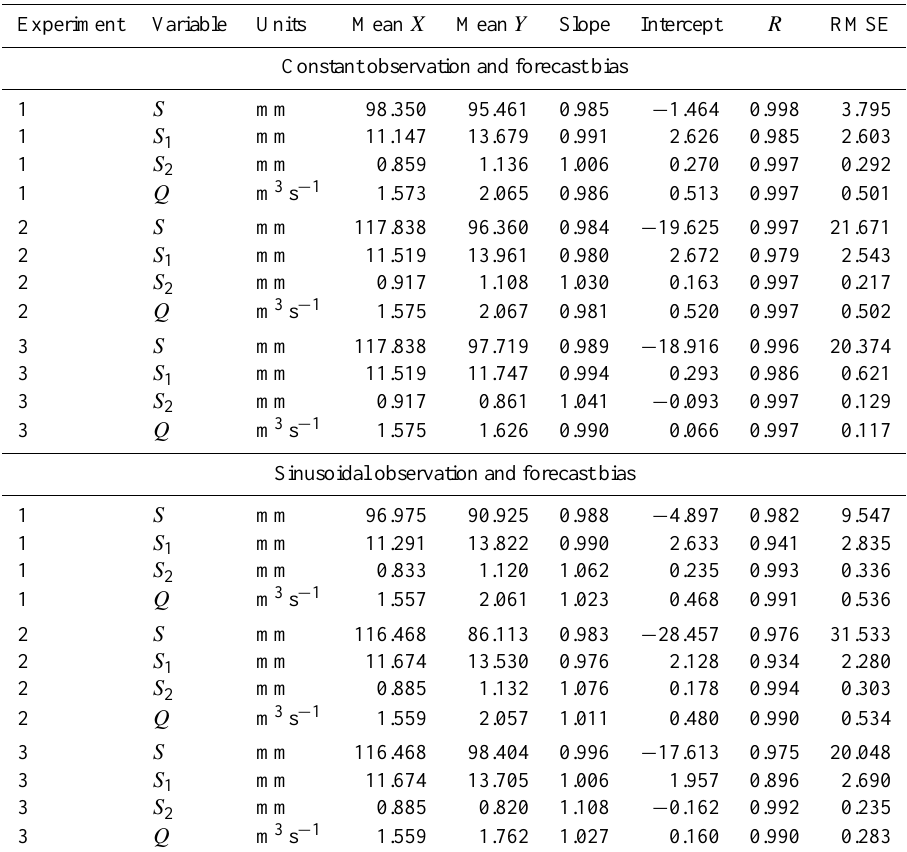
Table 4. Statistics of the linear regression between the true states and discharges ( X ) and the values obtained using an observation bias- unaware EnKF ( Y ).